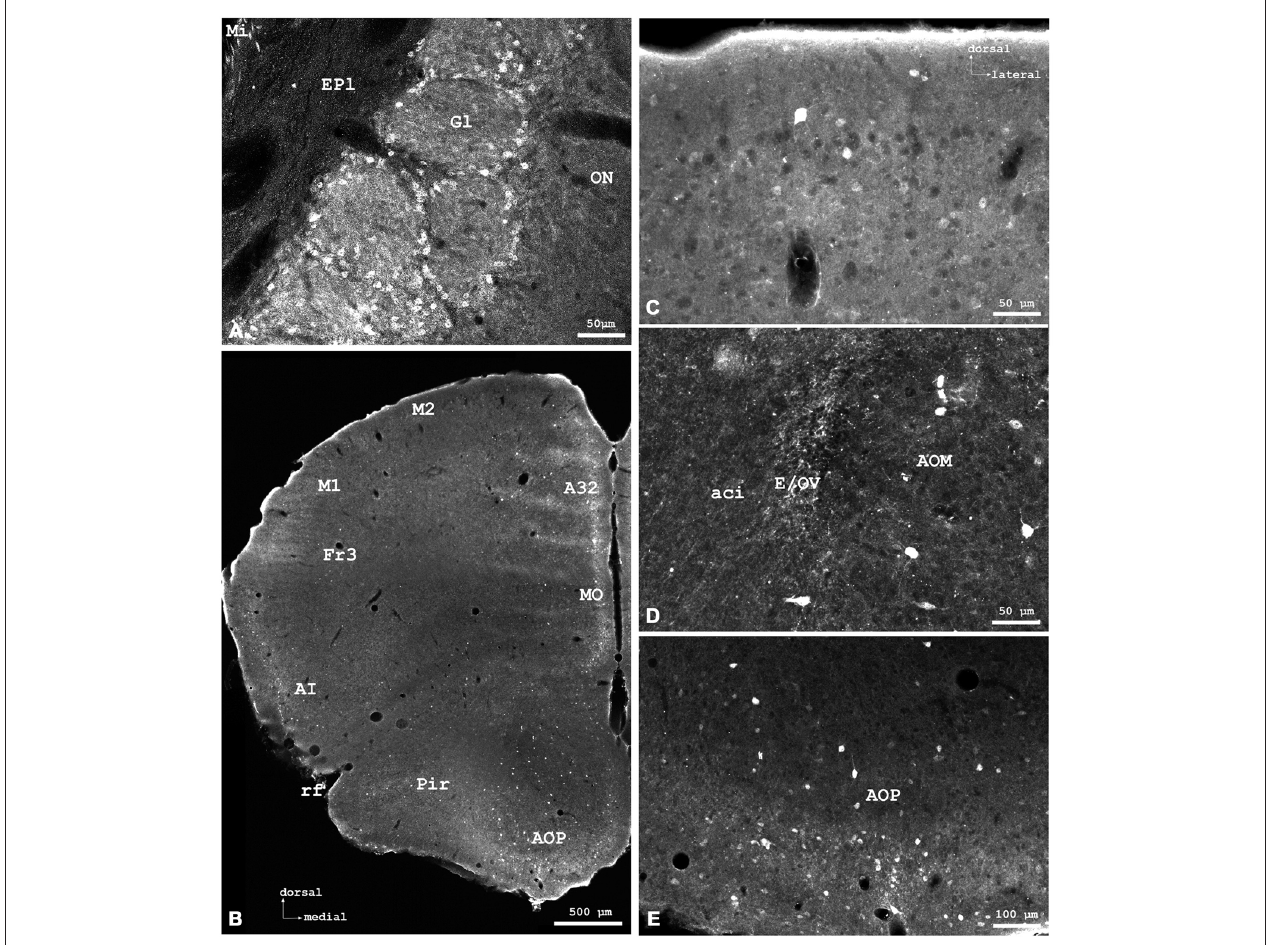
FIGURE 1 | Cytoglobin (Cygb)-immunofluorescence in frontal sections of the mouse brain. (A) Cygb-immunoreactive (Cygb-IR) periglomerular neurons in the glomerular layer (Gl) of the olfactory bulb, at the level of approximately interaural +8 mm, corresponding to Panel of the mouse brain atlas. (B) Low power photomicrograph “multiple image alignment” (MIA) showing orbital regions of the cerebral cortex (CCo) at the level of approximately interaural +6.0 mm, corresponding to Figure 12 of the mouse brain atlas. (C) Higher magnification of the section shown in (B) demonstrating strong and faintly labeled neurons in the secondary motor cortex. (D) Higher magnification from (B) showing sparse neurons and fibers in the anterior olfactory region. (E) Higher magnification from (B) demonstrating Cygb-neurons in the posterior part of the anterior olfactory area (AOP). Abbreviations: A32, cingulate cortex; ACI, intrabulbar part of the anterior commissure; AI, agranular insular cortex; AOM, medial part of the AOP; E/OV, ependyma of the olfactory ventricle; EPl, external plexiform layer of the olfactory bulb; M1/M2, primary/secondary motor cortex; Fr3, frontal cortex; Mi, mitral cell layer; MO, medial orbital cortex; ON, olfactory nerve layer; Pir, piriform cortex; rf, rhinal